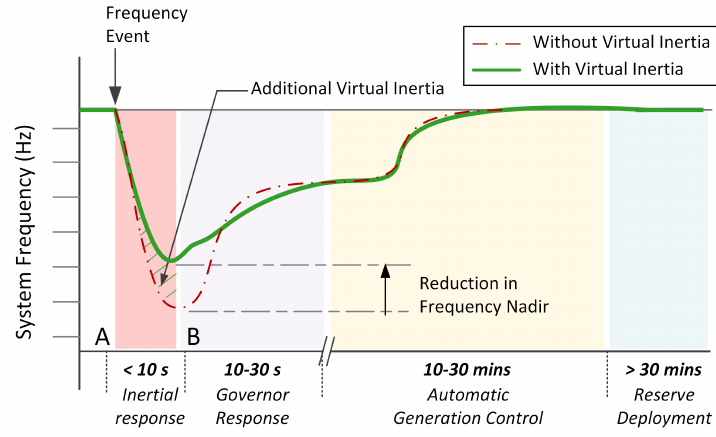
Figure 3. Multiple time-frame frequency response in a power system following a frequency